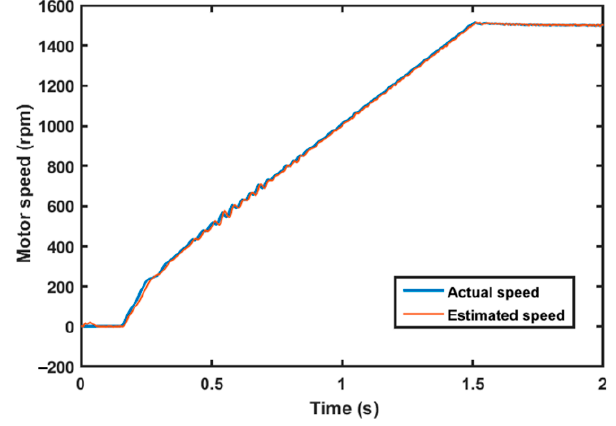
Figure 5. Motor speed during the startup process using the extended flux-based observer.